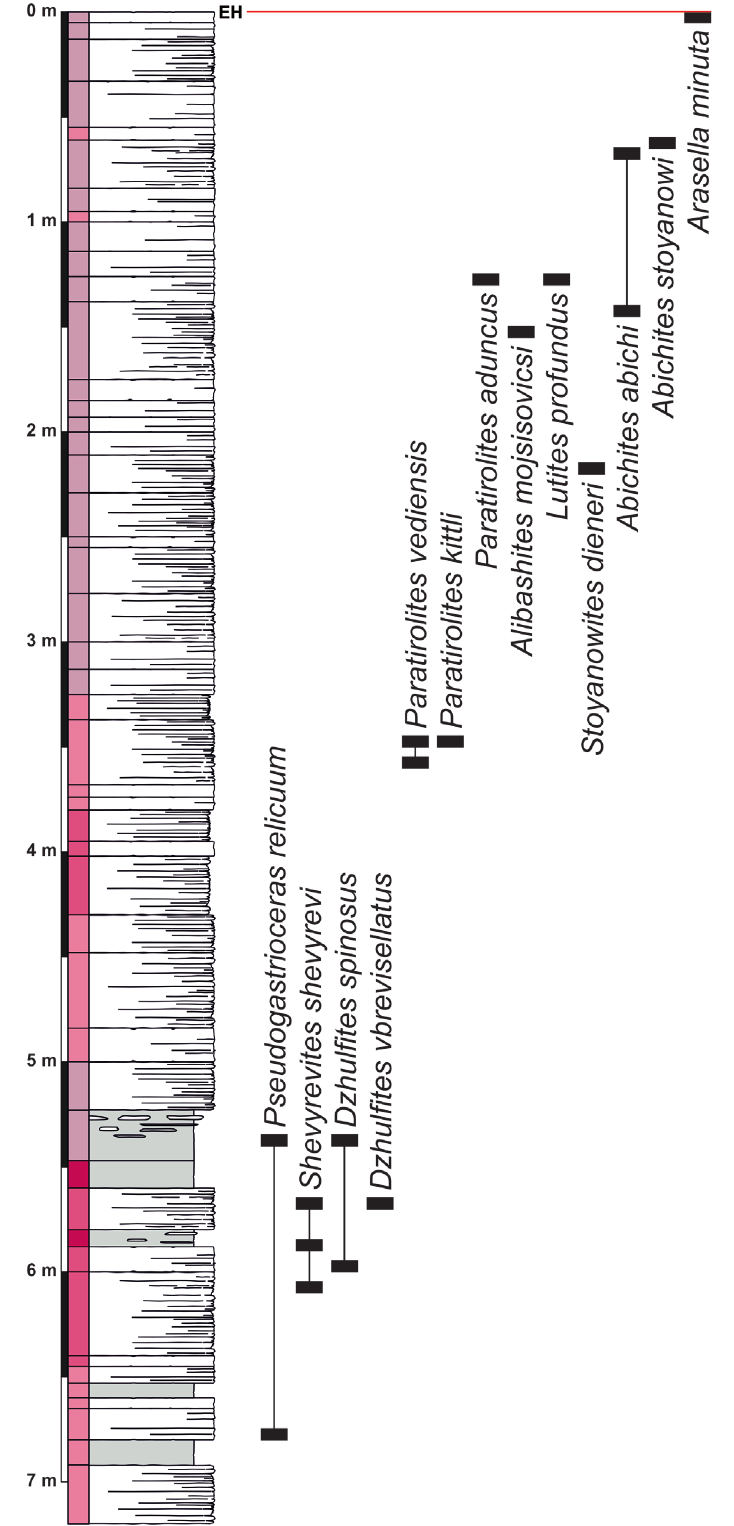
Fig. 9. The stratigraphic occurrence of the ammonoid species in the upper part of the Hambast Formation at Baghuk Mountain H section. EH = extinction